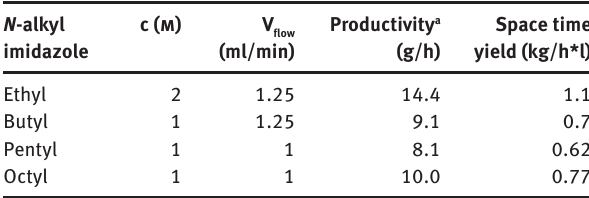
Table 3: Theoretical productivity and space time yield values based on the best reaction parameters (See Table 2,